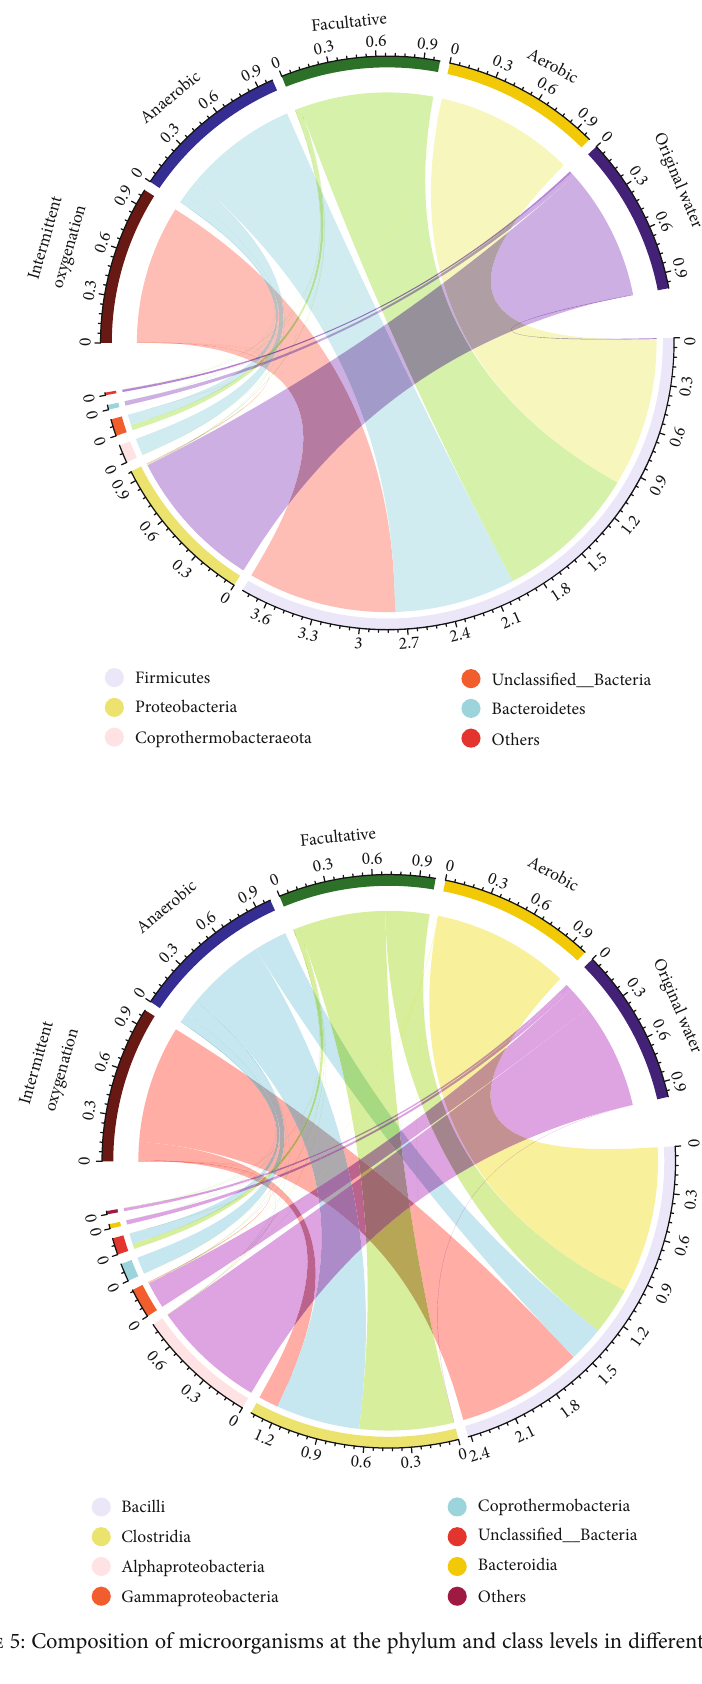
Figure 5: Composition of microorganisms at the phylum and class levels in di ff erent